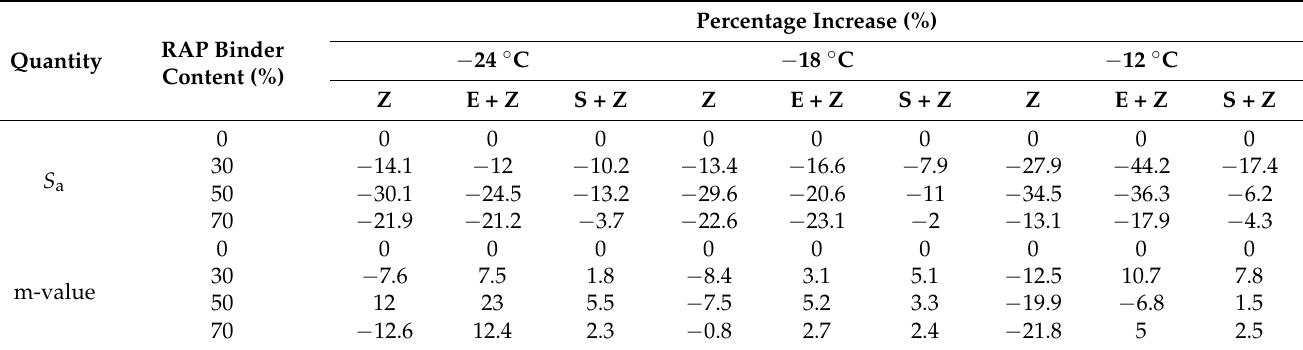
Table 11. Percentage increases of S a and m-value with the RAP binder content under the long-term aged condition.